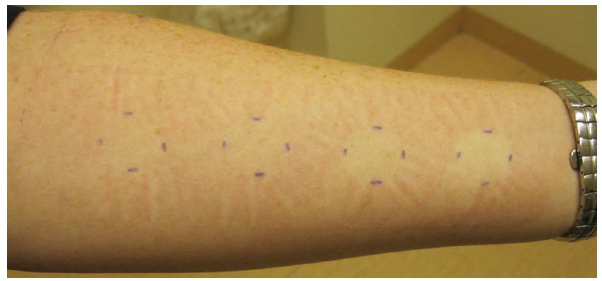
Figure 1. Blanching of the skin as a result of vasoconstriction, 7 hours after application of budesonide in increasing concen-